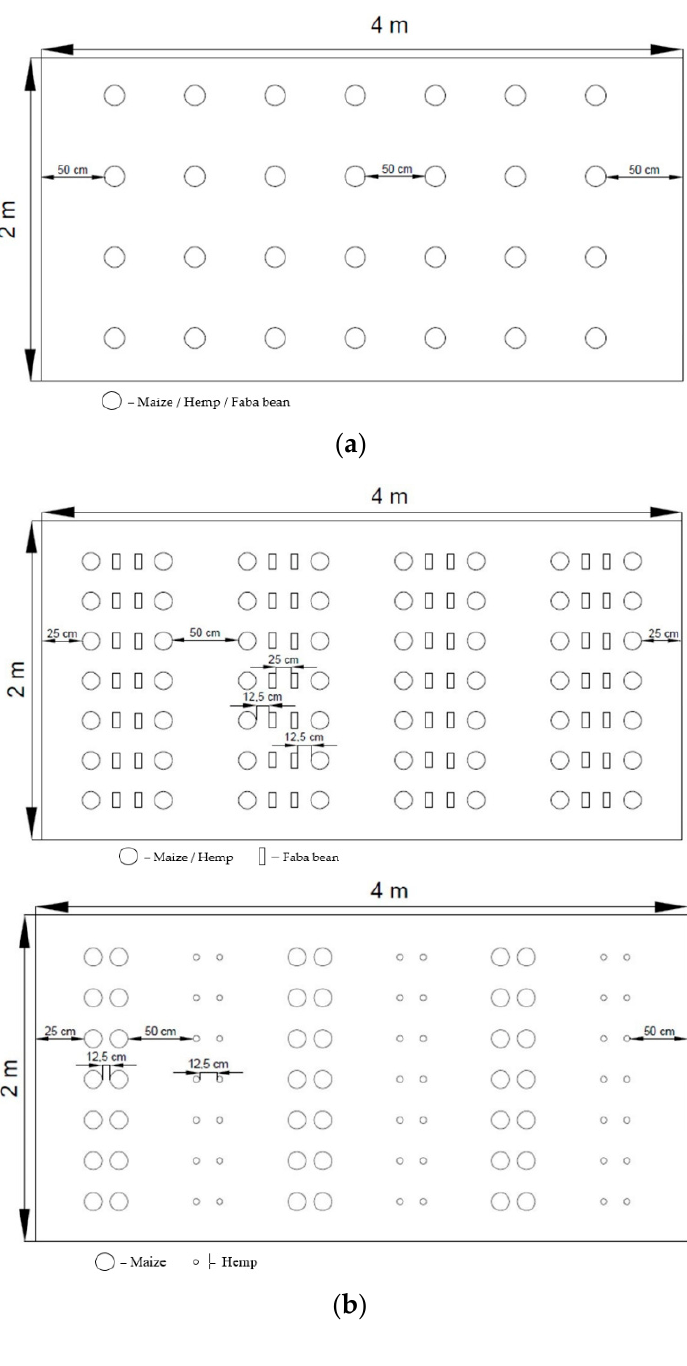
( c ) Figure 2. The sowing scheme of mono ( a ), binary ( b ) and ternary ( c ) cultivations. The weather temperature conditions during the 2020 and 2021 vegetative seasons varied. The month of May of both seasons, July 2020, and August 2021 were colder than usual (Table 2). Precipitation was distributed unevenly. March and April of 2020 were arid, whereas May and June saw surplus water. In 2021, as in 2020, the beginning of spring was dry, but May and August were extremely humid. Such variation of meteo-conditions could have negatively influenced the soil properties. Table 2. Average air temperature and rainfall during vegetative seasons. Data from the Kaunas meteorological station. Months